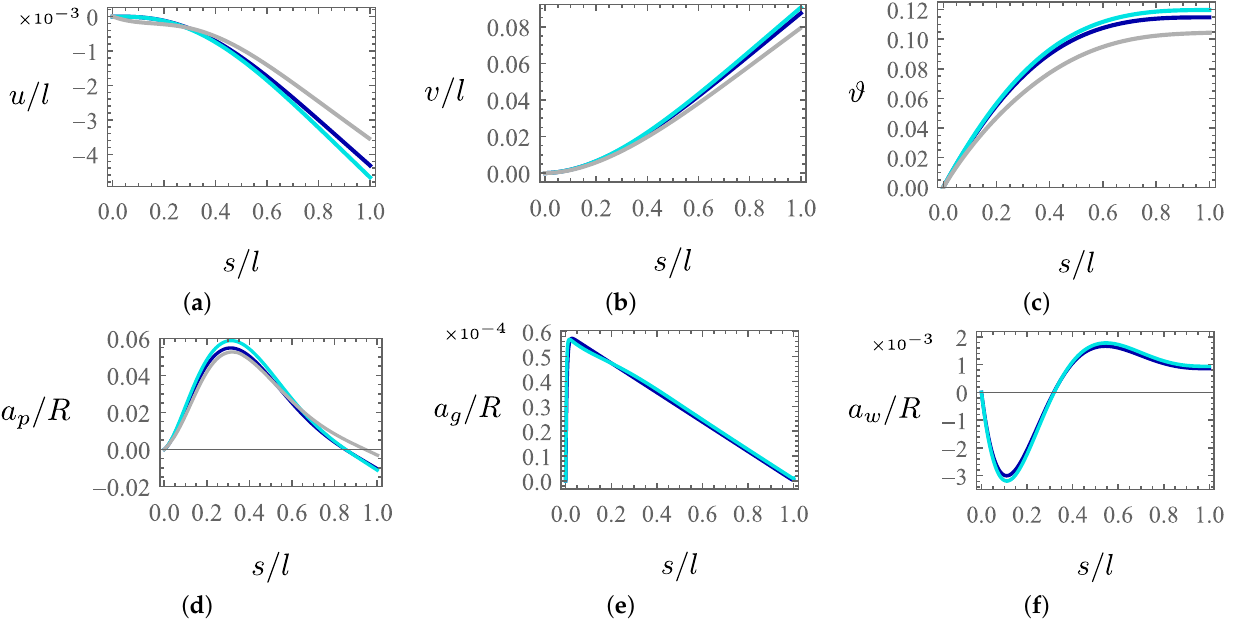
Figure 4. Response in the case of the uniformly distributed vertical load: ( a ) longitudinal displacement u / l ( × 10 − 3 ) ; ( b ) v / l ; ( c ) transversal displacement ϑ ( rad ) ; ( d ) amplitude of ovalization a p / R ; ( e ) amplitude of relative sliding a g / R ; ( f ) amplitude of warping a w / R . Blue lines: perturbation solution; light blue lines: finite difference method; gray lines: